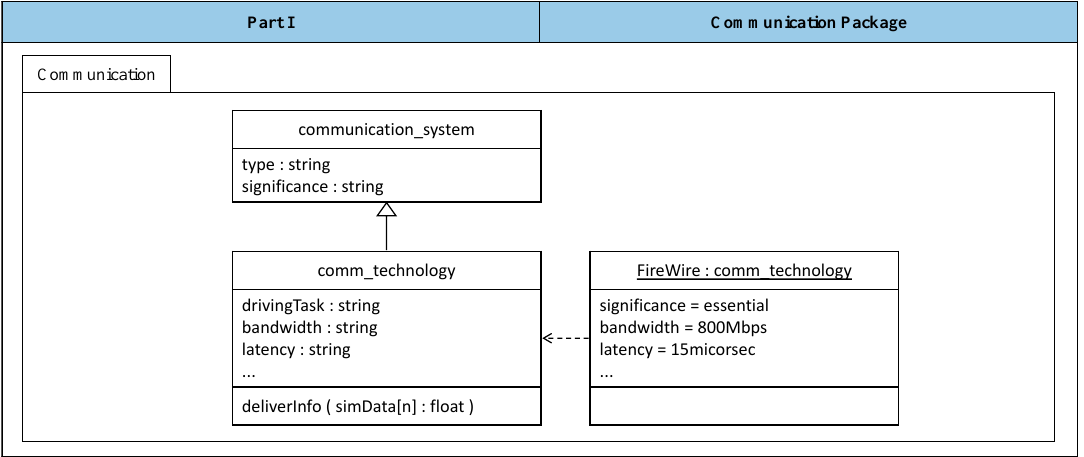
Figure 16. UML class diagram of the selected communication system components—package 2.